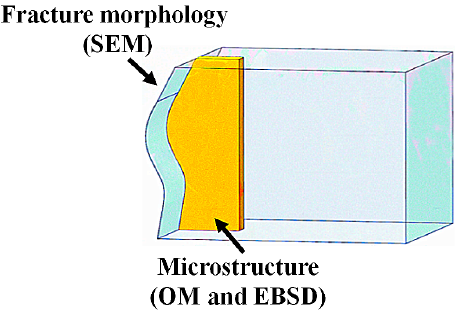
Figure 3. Schematic diagram of specimen locations in the OM, SEM and EBSD.